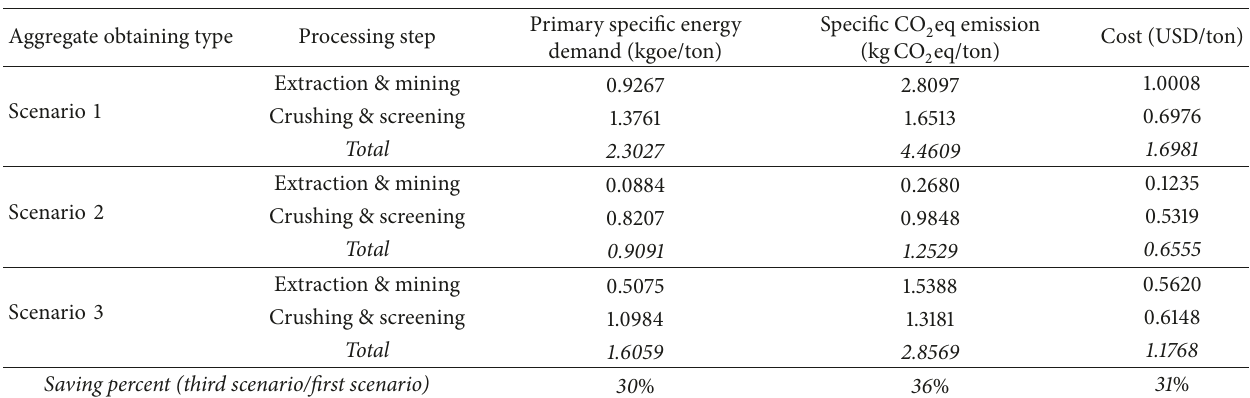
Table 6: The economic and environmental detailed results for the research